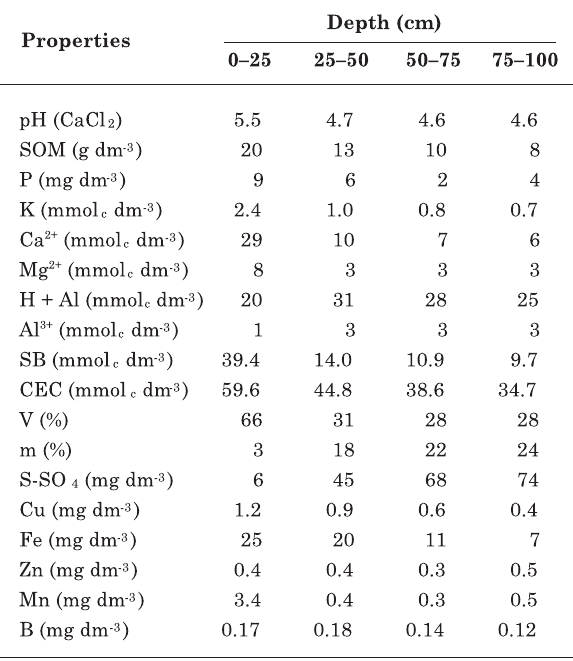
Table 1. Chemical properties of soil samples from the experimental area obtained from sampling between the rows of the previous